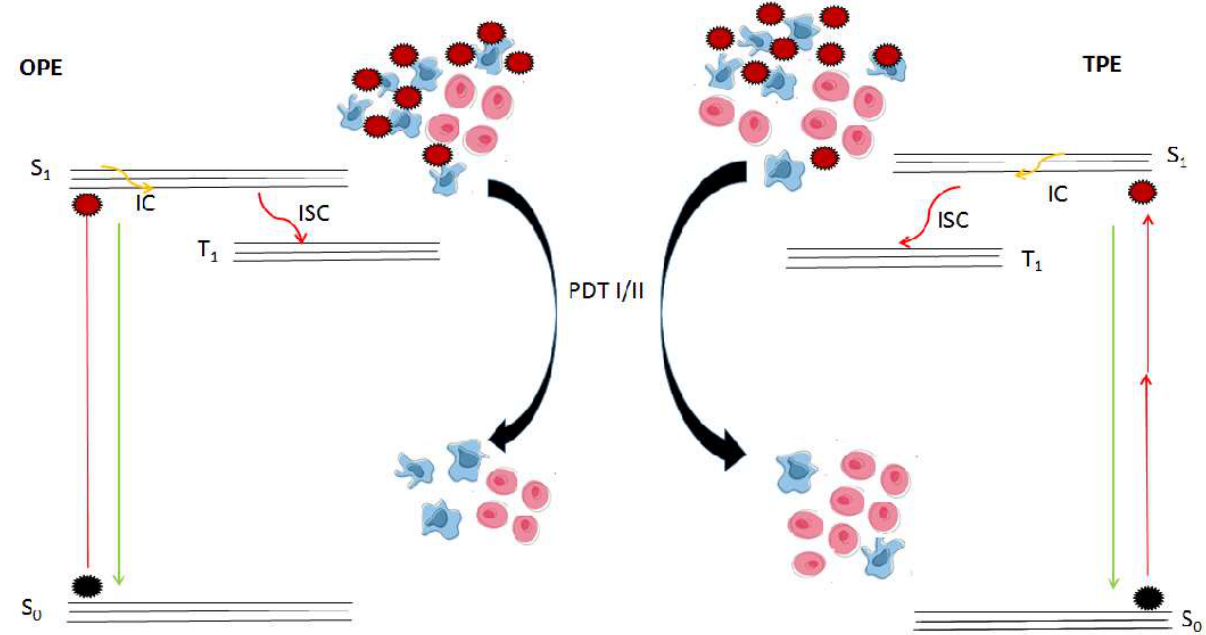
Figure 1. Modified Jablonski diagram. Different states of photosensitizers (PSs) from the ground state (S 0 ) to the activated or excited state (S 1 ) to fluorescence or conversion (IC and ISC) into the excited triplet state (T 1 ). Triplet state PSs induce photodynamic reactions (PDT I/II), killing of diseased cells, and a reduction in tumor. PSs (S 0 ) are excited through one (OPE) or two (TPE) photon routes. The tumor-size is reduced in both routes, but normal cell growth is being promoted with TPE.